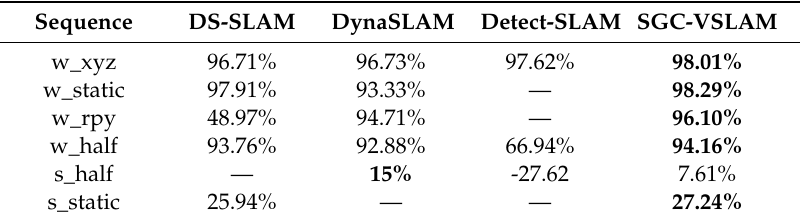
Figure 6. The SLAM trajectory in the low-dynamic sequence. Three systems were tested on the low dynamic sequences. The same row in the figure is the test results of the systems on the same test sequence. The first column in the figure represents the test results of ORB-SLAM2, the second column denotes SGC-VSLAM (IQ) and the third column is the test trajectory of SGC-VSLAM.